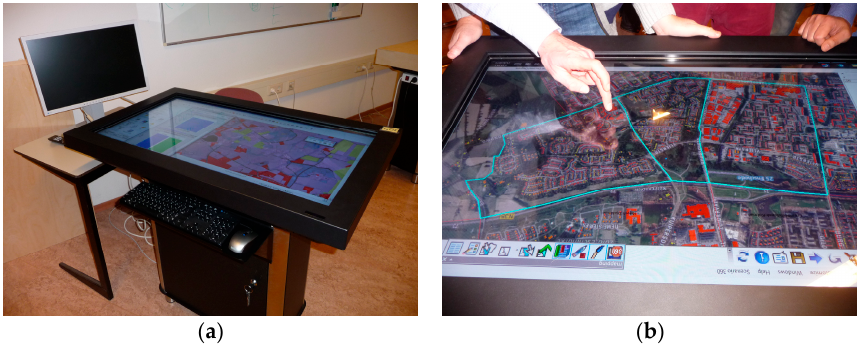
Figure 1 . The interactive maptable: ( a ) the entire maptable setup including a second screen; ( b ) participants interacting with the maptable during a workshop session.